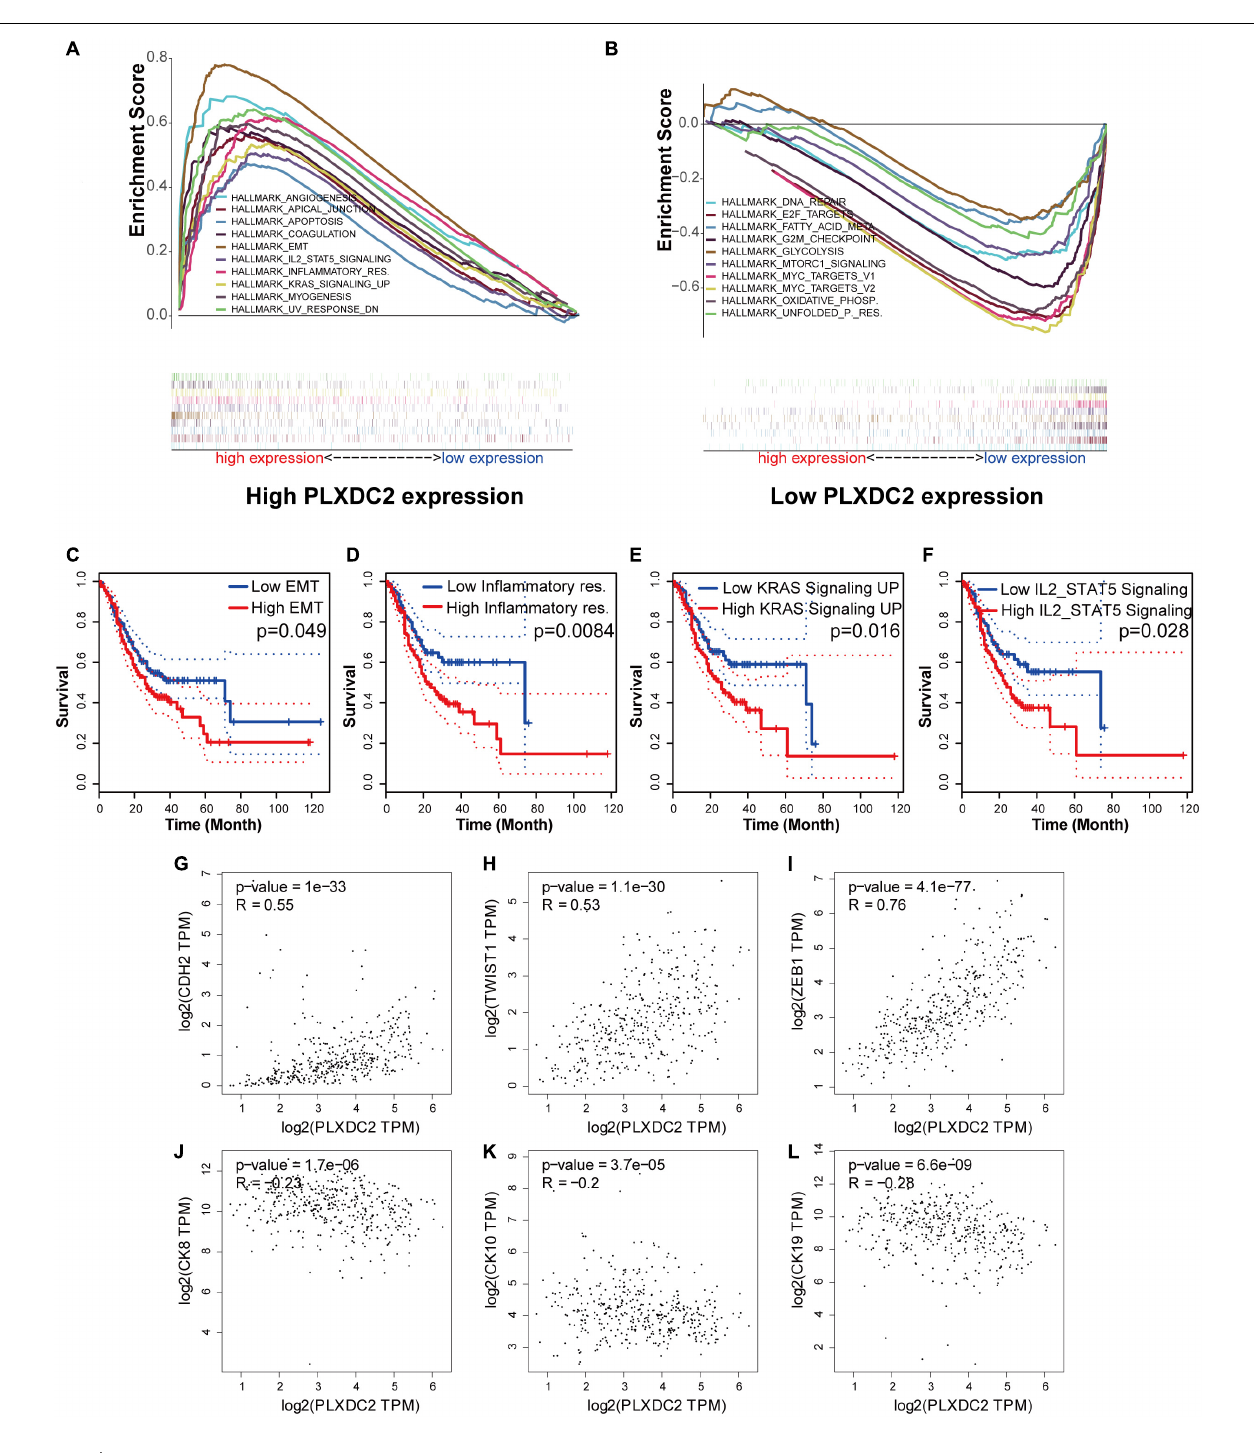
FIGURE 4 | PLXDC2 is relevant to EMT and several immune-related pathways. (A) Up-regulated HALLMARK pathways in samples with high PLXDC2 expression. Particular gene sets are represented with lines of unique color, and up-regulated genes are located on the left approaching the origin of the coordinates, while the down-regulated genes are on the right of the x -axis. Only gene sets with NOM p < 0.05 and FDR q < 0.06 were considered significant. Several leading gene sets are displayed in the plot. (B) Down-regulated HALLMARK pathways in samples with low PLXDC2 expression, similar to (A) . (C–F) Kaplan–Meier plots according to the expression of DEGs within the top 10 up-regulated pathways. EMT and 3 other pathways, namely, inflammatory response, IL2-STAT5 signaling and KRAS signaling (up), were proven to be related to survival. (G–L) The correlation scatterplots of PLXDC2 and EMT markers. CDH2 (N-cadherin), TWIST1 and ZEB1 are up-regulated EMT markers, while CK8, CK10, and CK19 (three E- cadherin genes) are down-regulated EMT markers.